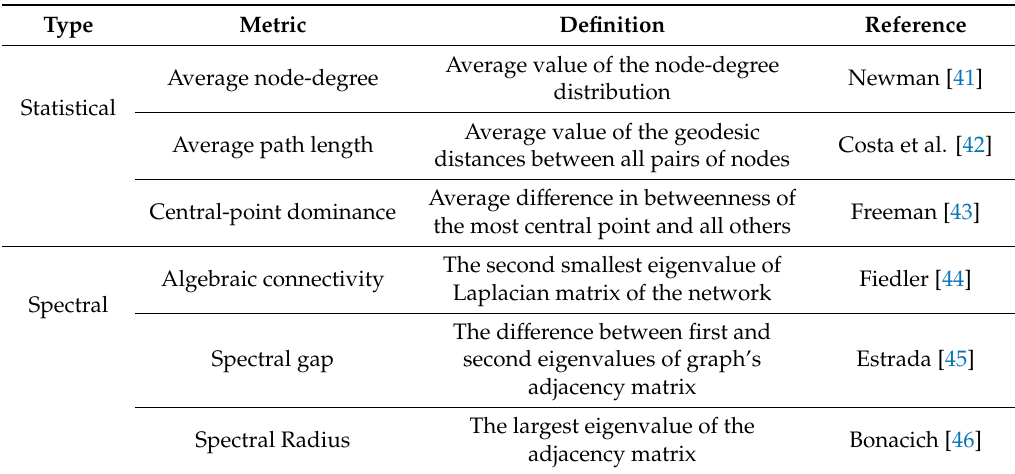
Table 2. Summary of structural ROB indicators based on graph